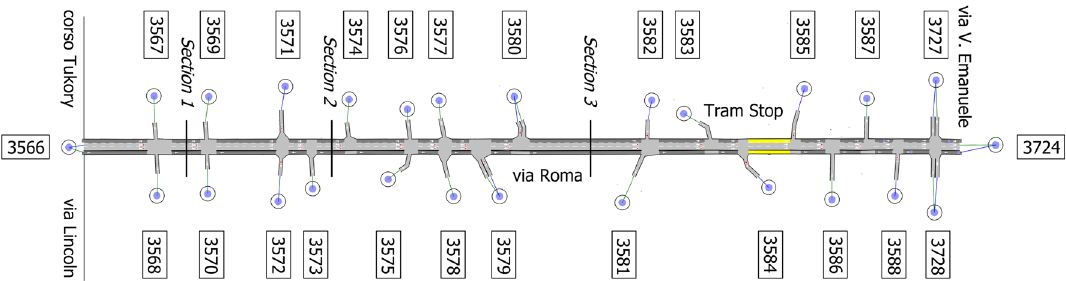
Fig. 7 Road segment of Line A (‘‘Via Roma’’) implemented in AIMSUN 8.0.8 (Type A section, cfr. Fig. 6) with centroids (cfr.